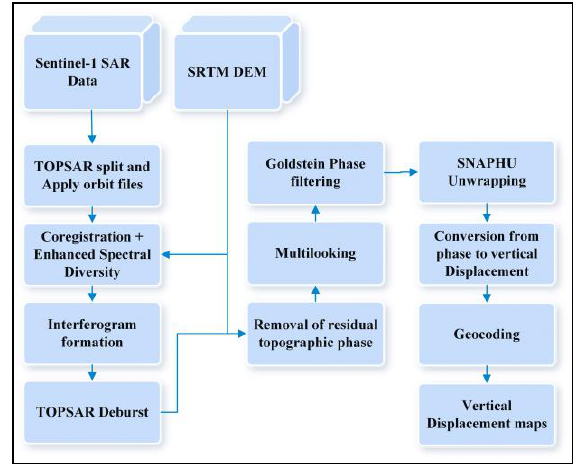
Figure 2. The conventional DInSAR workflow